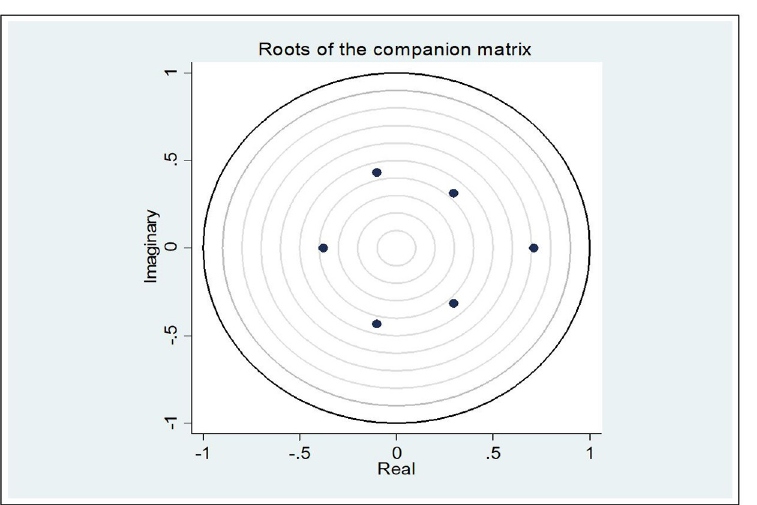
Fig 3. Stability